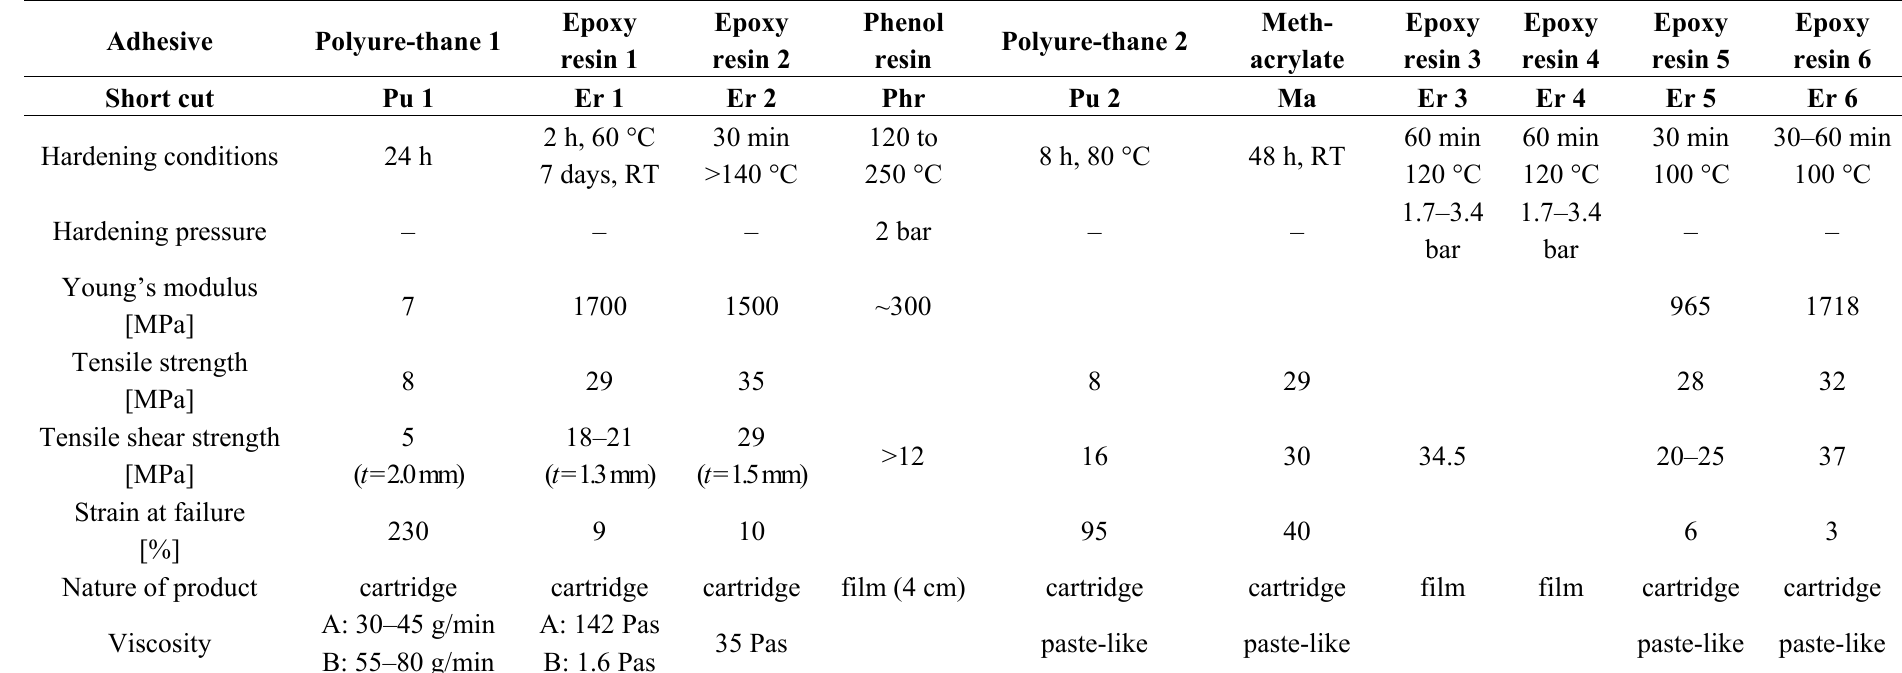
Table 2. Summary of the investigated adhesive systems